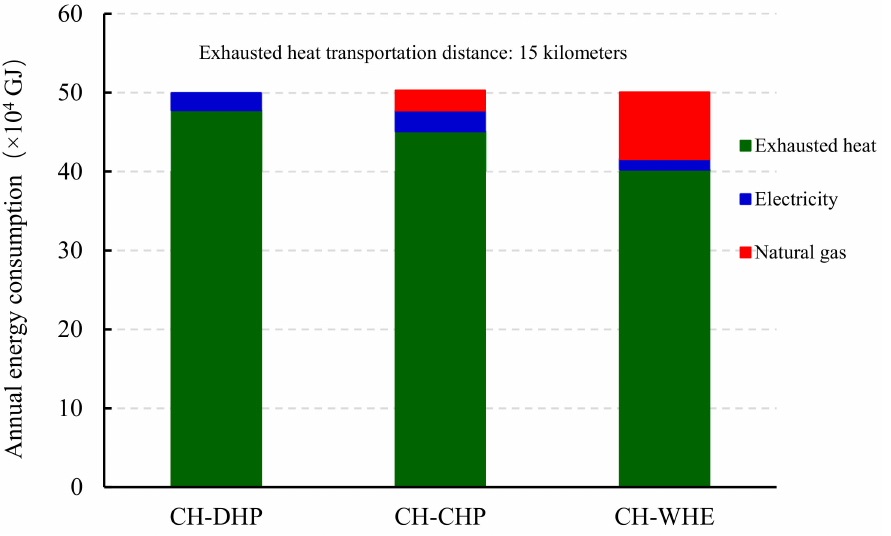
Figure 8. Composition of annual energy